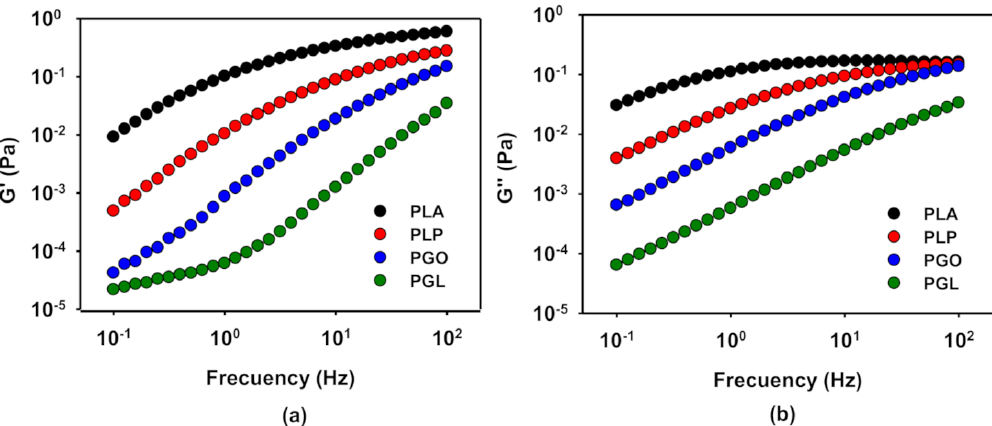
Figure 8. Representation of the viscoelastic properties, G’ ( a ) and G” ( b ), in a sweep frequency test at 130 ◦ C for PLA and its GO, IL, and IL-modified GO derivatives.